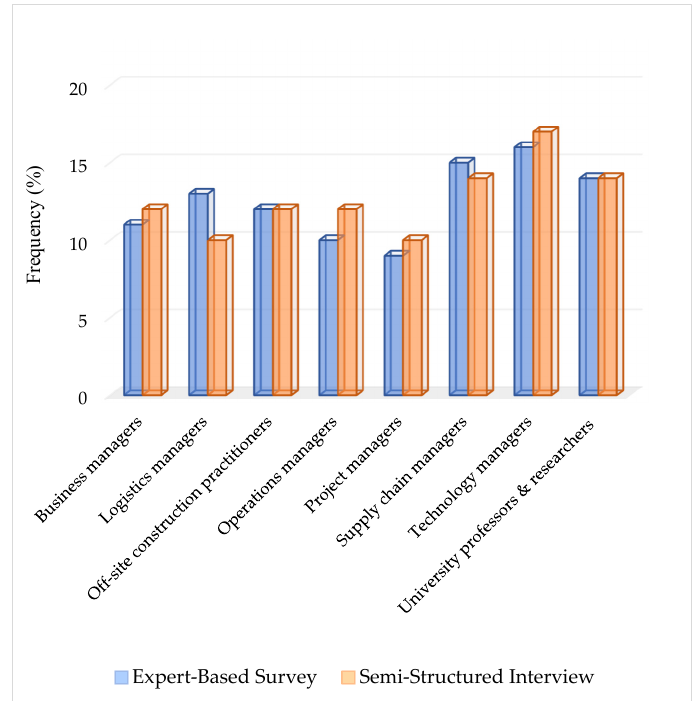
Figure 1. Categories of the experts involved in the data collection. Table 2. Final list of the IoT utilization constraints with their